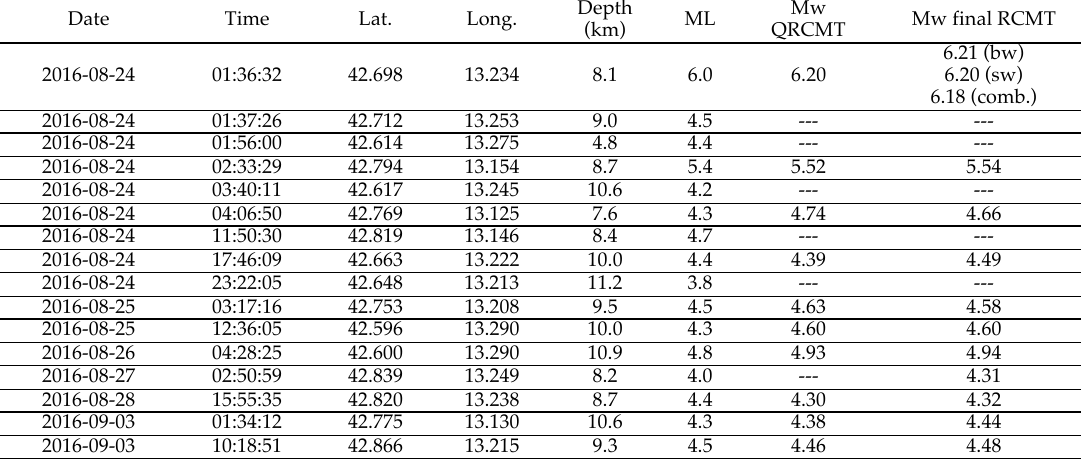
Table 1. List of events for which a trial to compute a QRCMT has been done. Locations and ML are from INGV CNT first determination (cnt.rm.ingv.it), Mw QRCMT are from autorcmt.bo.ingv.it/quicks.html and Mw RCMT are for revised solution from this paper. Different values for Mw of the main shock are from the inversion for different signals: bw – only body waves; sw – only surface waves; comb. – body and surface waves